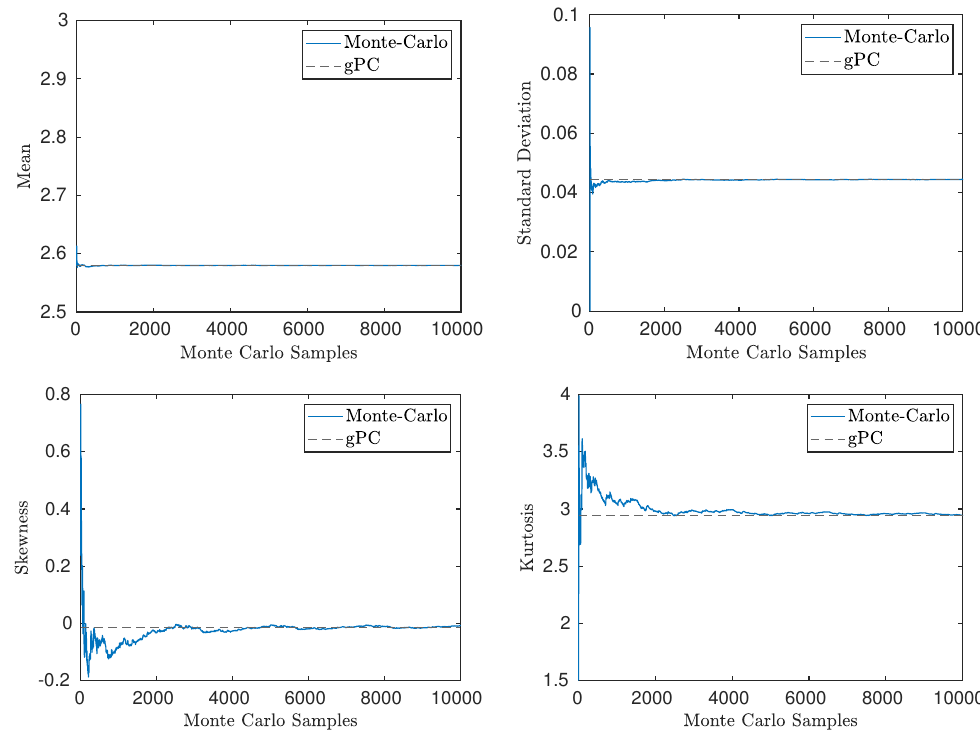
Figure 4. Uncertainty Quantification (UQ) in the Lorenz-96 model ( N = 40 and T = 100), for the QoI (32). Comparison of statistical moments computed by Monte–Carlo and generalized Polynomial Chaos (gPC) for ( N = 40 and T = 100) c =